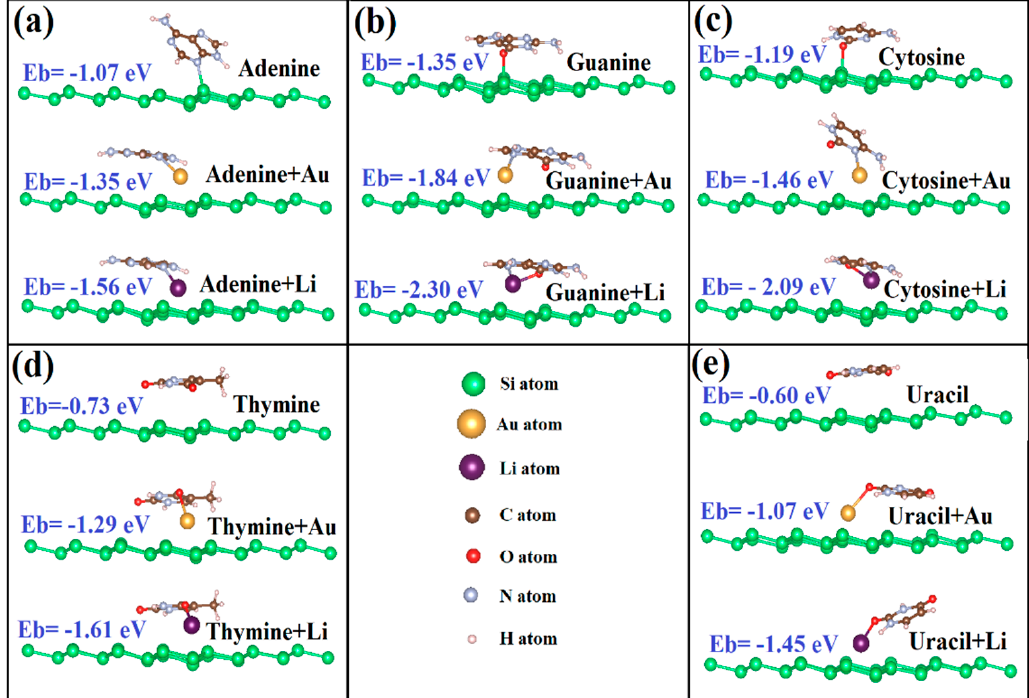
Figure 3. Optimized geometric structures and binding energies of nucleobases on bare and Li/Au-supported silicene. ( a ) Adenine, ( b ) Guanine, ( c ) Cytosine, ( d ) Thymine, and ( e ) Uracil.